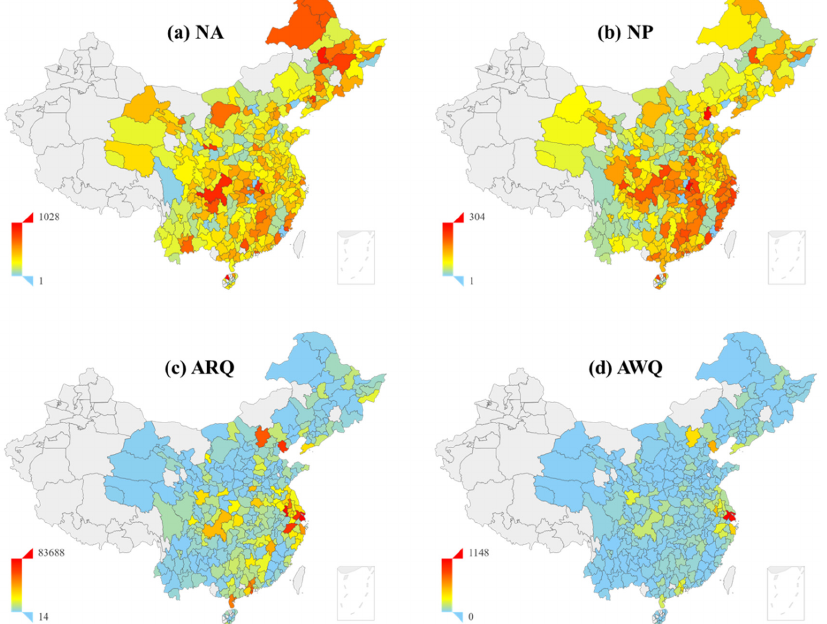
Figure 1. Regional distribution of emergency response and risk communication effects. Note: ( a ) The distribution of the number of articles (NA) in Chinese cities. ( b ) The distribution of the number of posts (NP) in Chinese cities. ( c ) The distribution of the average reading quantity (ARQ) of the articles in Chinese cities. ( d ) The distribution of the average wow quantity (AWQ) of articles in Chinese cities.